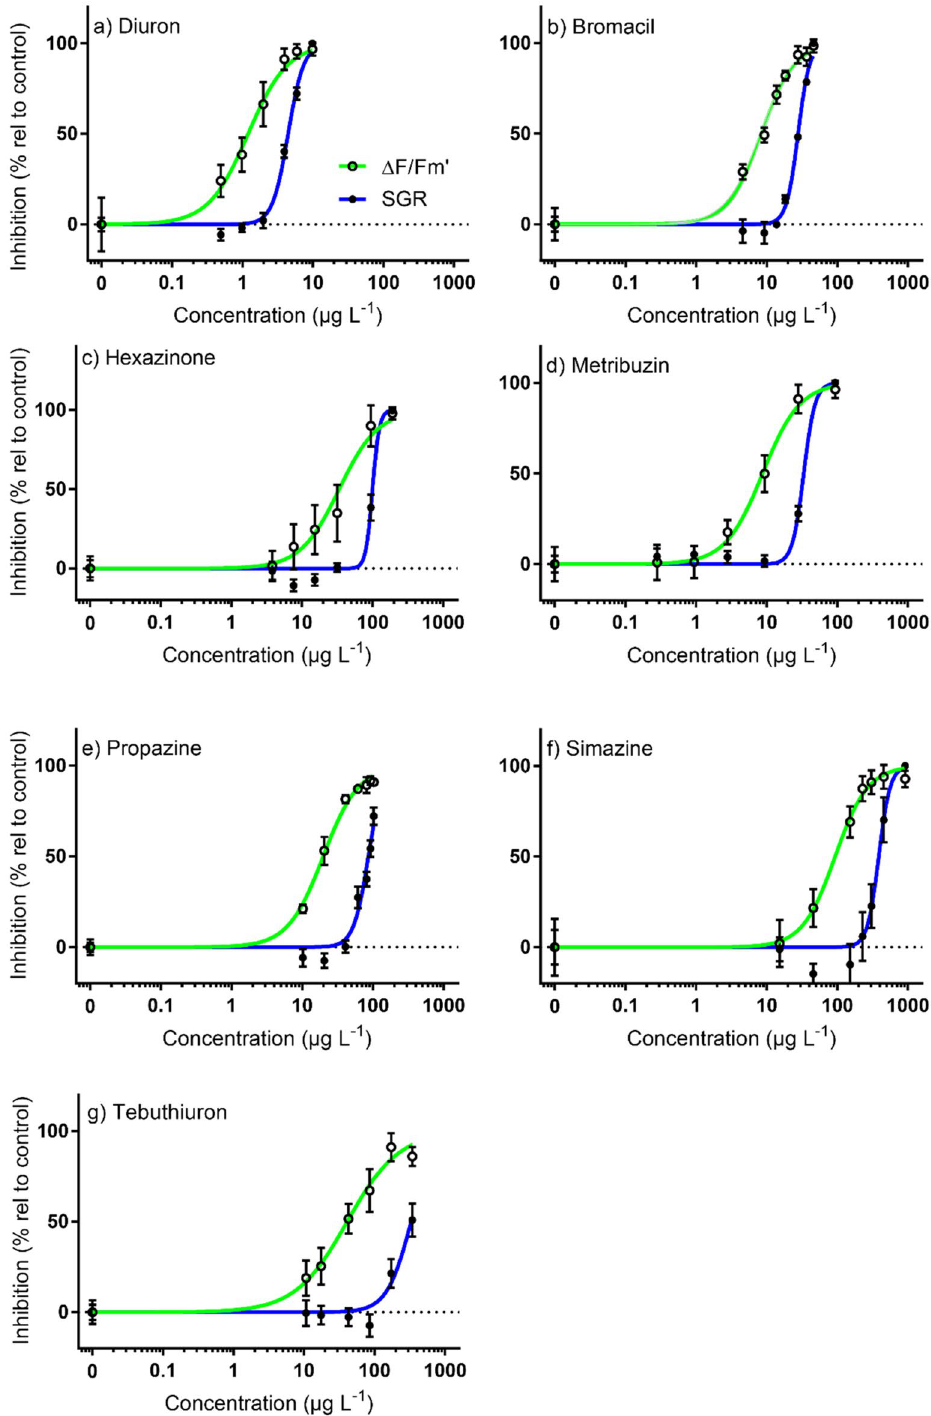
Figure 1. Concentration–response curves for Cladocopium goreaui on the relative percent inhibition of 14-day specific growth rate (SGR; closed circle, mean ± SD) and effective quantum yield (ΔF/F m ′ ; open circle, mean ± SD) following herbicide exposure to ( a ) diuron; ( b ) bromacil; ( c ) hexazinone; ( d ) metribuzin; ( e ) propazine; ( f ) simazine; and ( g ) tebuthiuron at increasing concentrations. Sigmoidal, 4-parameter curve fit (solid line). All concentrations in µg L −1 (n = 4–6 per test; error bars not visible are smaller than